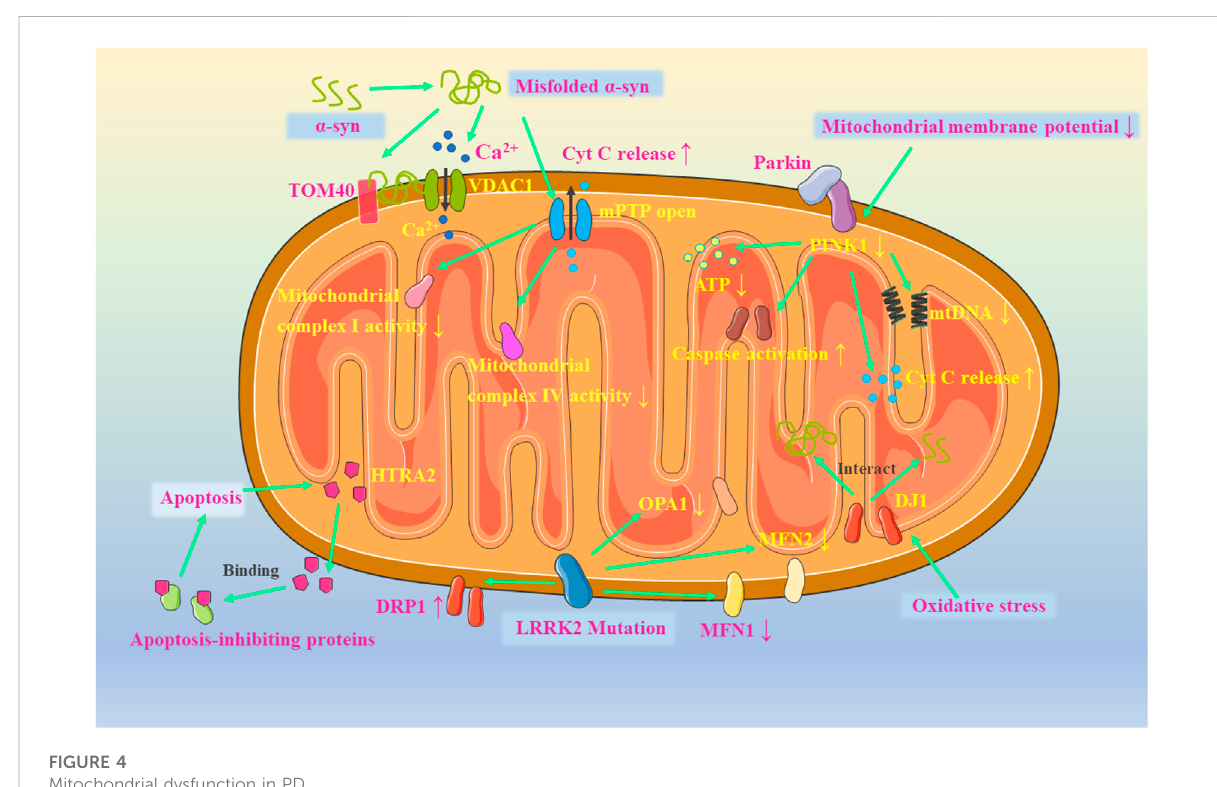
FIGURE 4 Mitochondrial dysfunction in